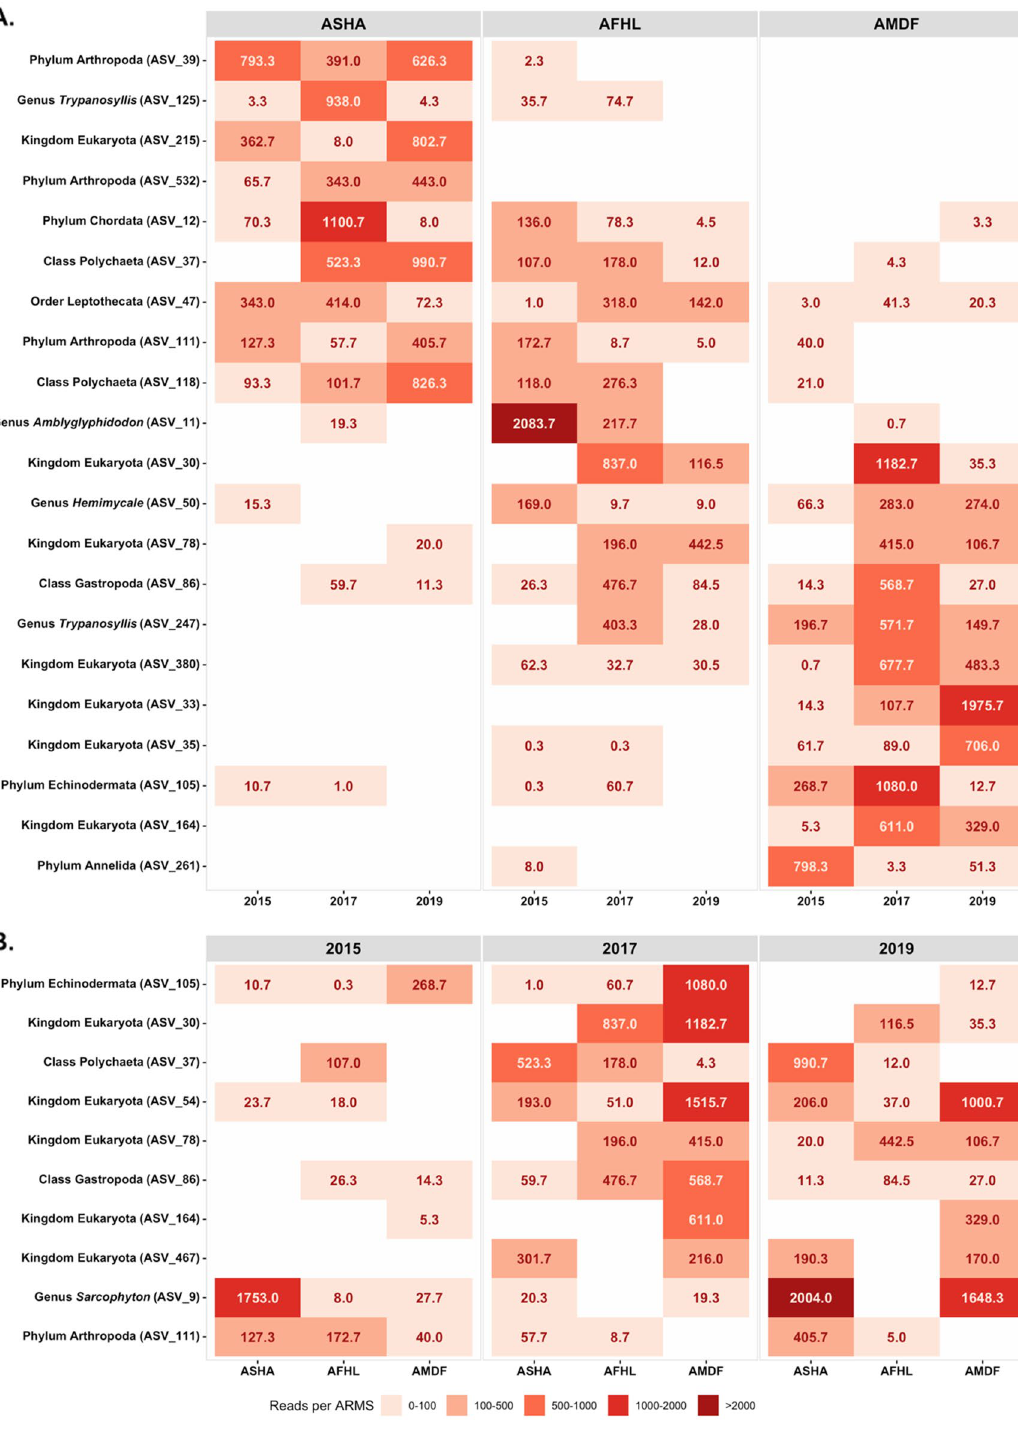
Figure 6. Average number of reads per ARMS of the indicator taxa observed for the metabarcoding fraction by reef ( A ) and sampling year ( B ). ASHA Abu Shoosha reef, AFHL Al Fahal, AMDF Abu factor. Eight indicator ASVs increased in abundance in 2017 (ASV_105, ASV_30, ASV_37, ASV_54, ASV_78, ASV_86, ASV_164, ASV_467) in 2017. And two (ASV_9 and ASV_11) in 2019. Environmental drivers shaping the spatio‑temporal community patterns. For the > 2000 µm fraction the first axis of the distance-based redundancy analysis (dbRDA) explained 11.8% of the constrained variation with the cross-shelf gradient being evident along this axis especially for the 2017 and 2019 samples (Fig. 7A). Hard coral cover was associated with the first axis and particularly with the 2017 and 2019 Abu Madafi